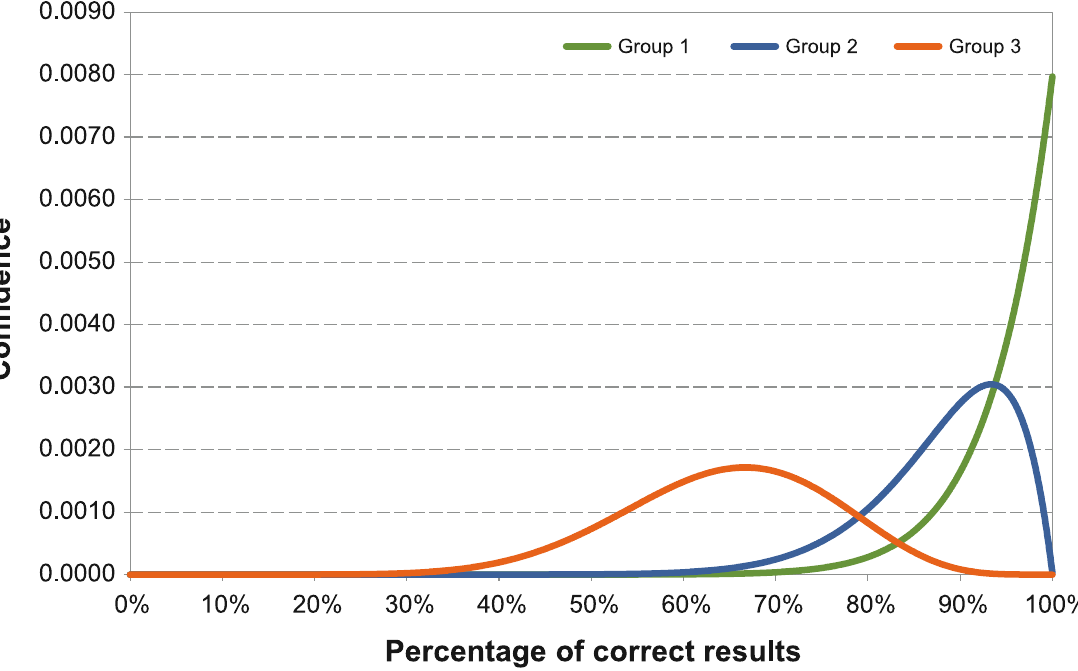
Fig 1. Distribution of the correct results of laboratories participating to EQA for RVFV genome detection. Group 1 represents laboratories which correctly classified 15 out of the 15 tested samples (#1a, #7, #8, #9, #10). Group 2 represents the laboratory failing to one test result (#1). Group 3 represents the laboratory, which misidentified 5 test results